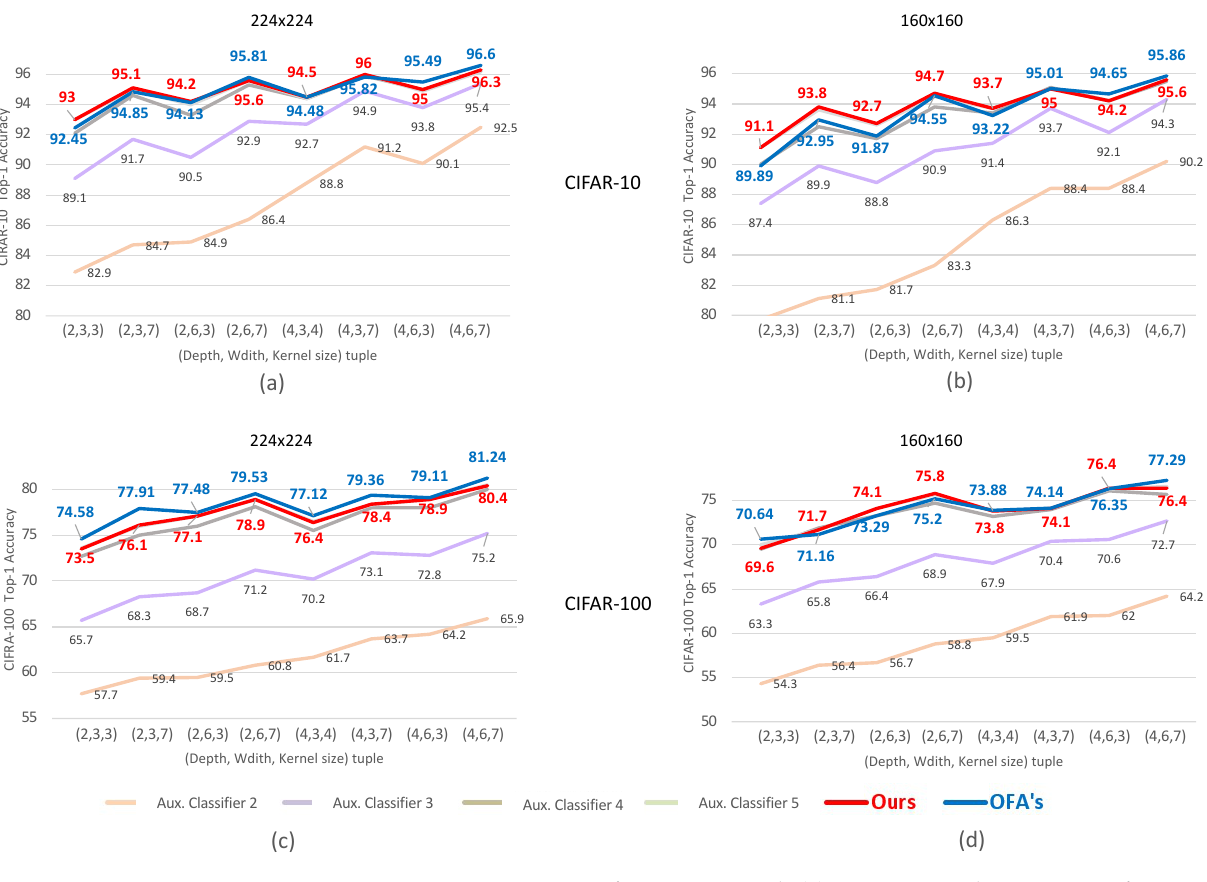
Figure 4. Accuracy comparison of SuperNets with ( a ) CIFAR-10 and image size of 224 × 224, ( b ) CIFAR-10 and 160 × 160, ( c ) CIFAR-100 and 224 × 224, and ( d ) CIFAR-100 and 160 ×